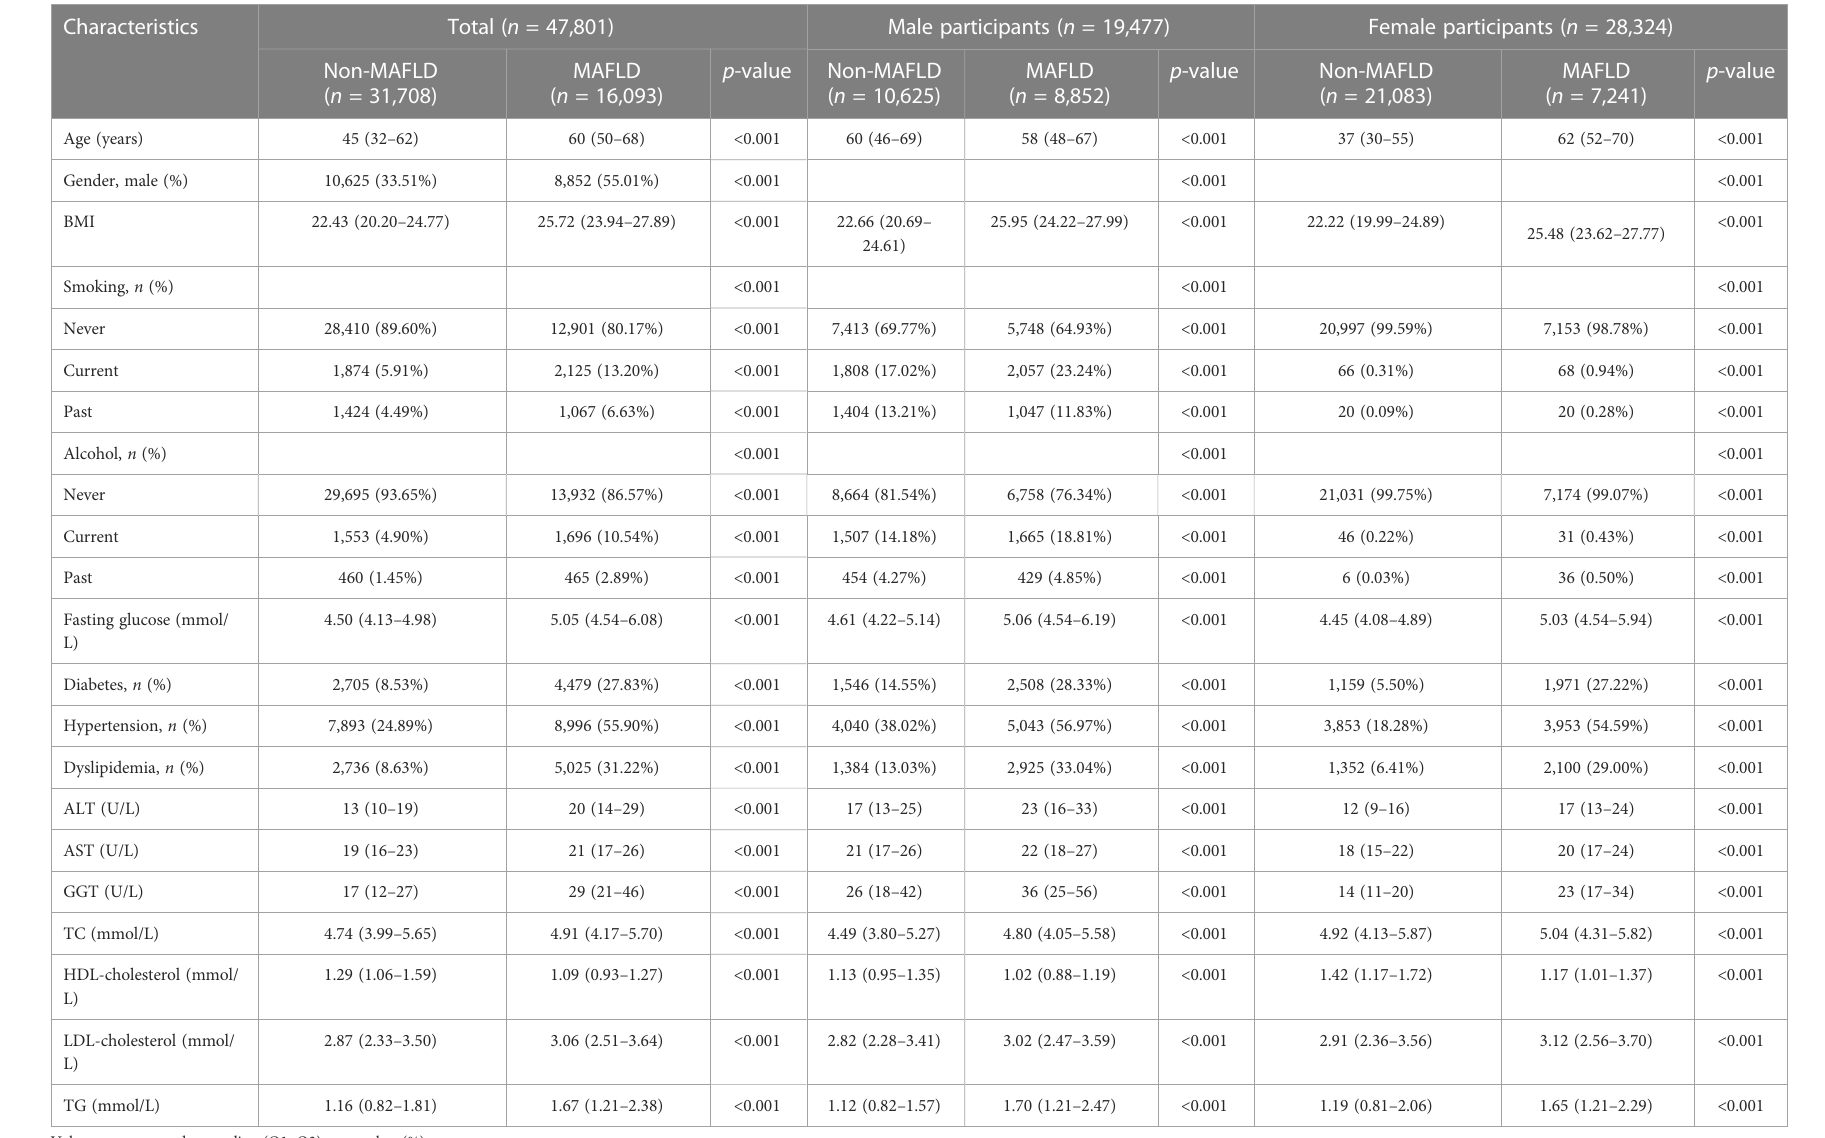
TABLE 1 Baseline characteristics of the study